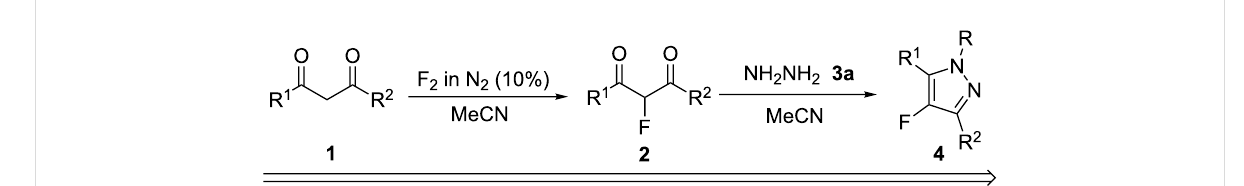
Table 2: Synthesis of 4-fluoropyrazole